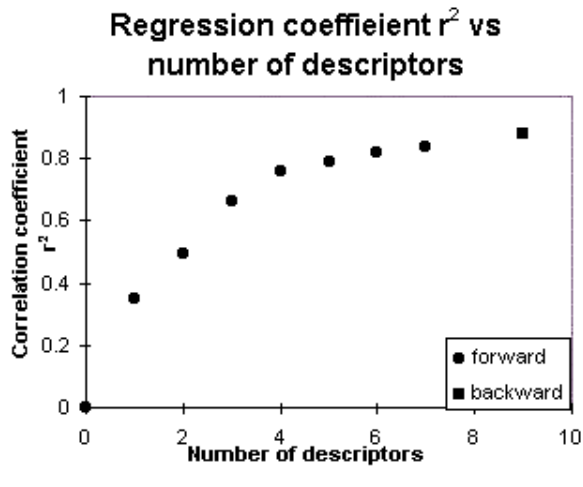
Figure 3. The correlation r 2 versus number of